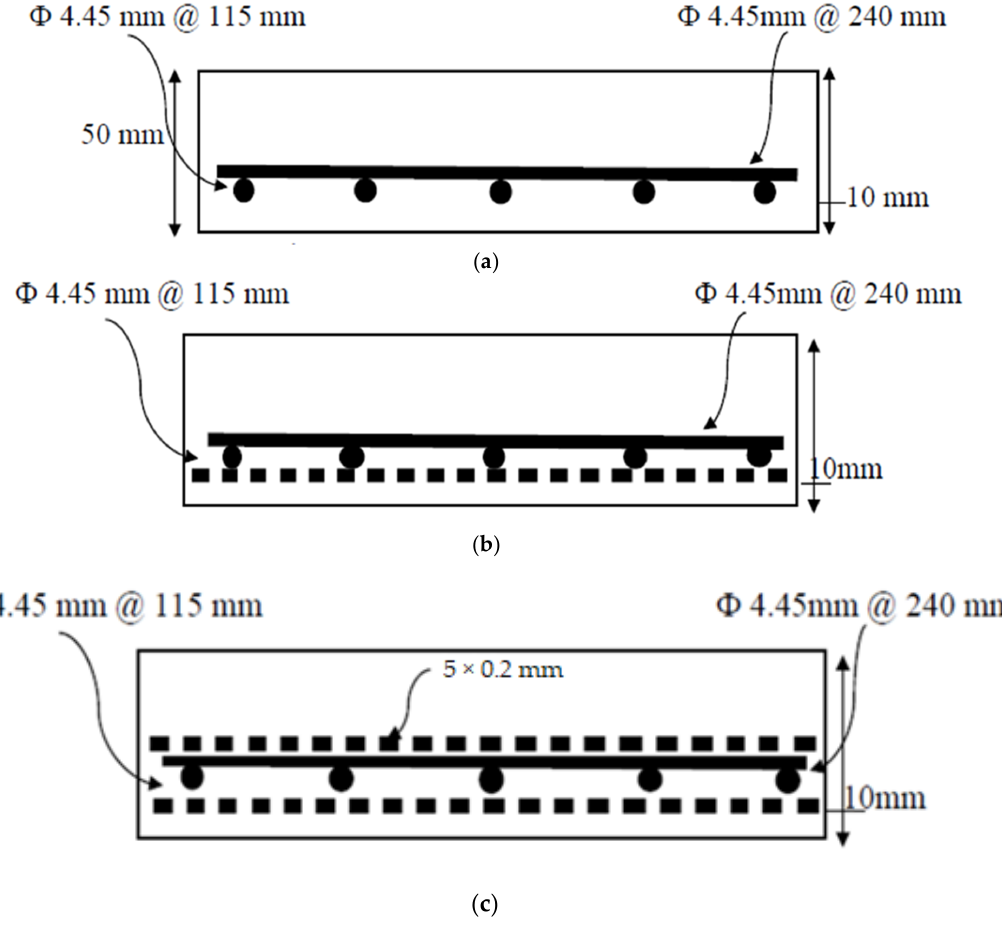
Figure 3. Reinforcement details for the three tested slabs. ( a ) SRC reinforcement details. ( b ) SRC + 1T